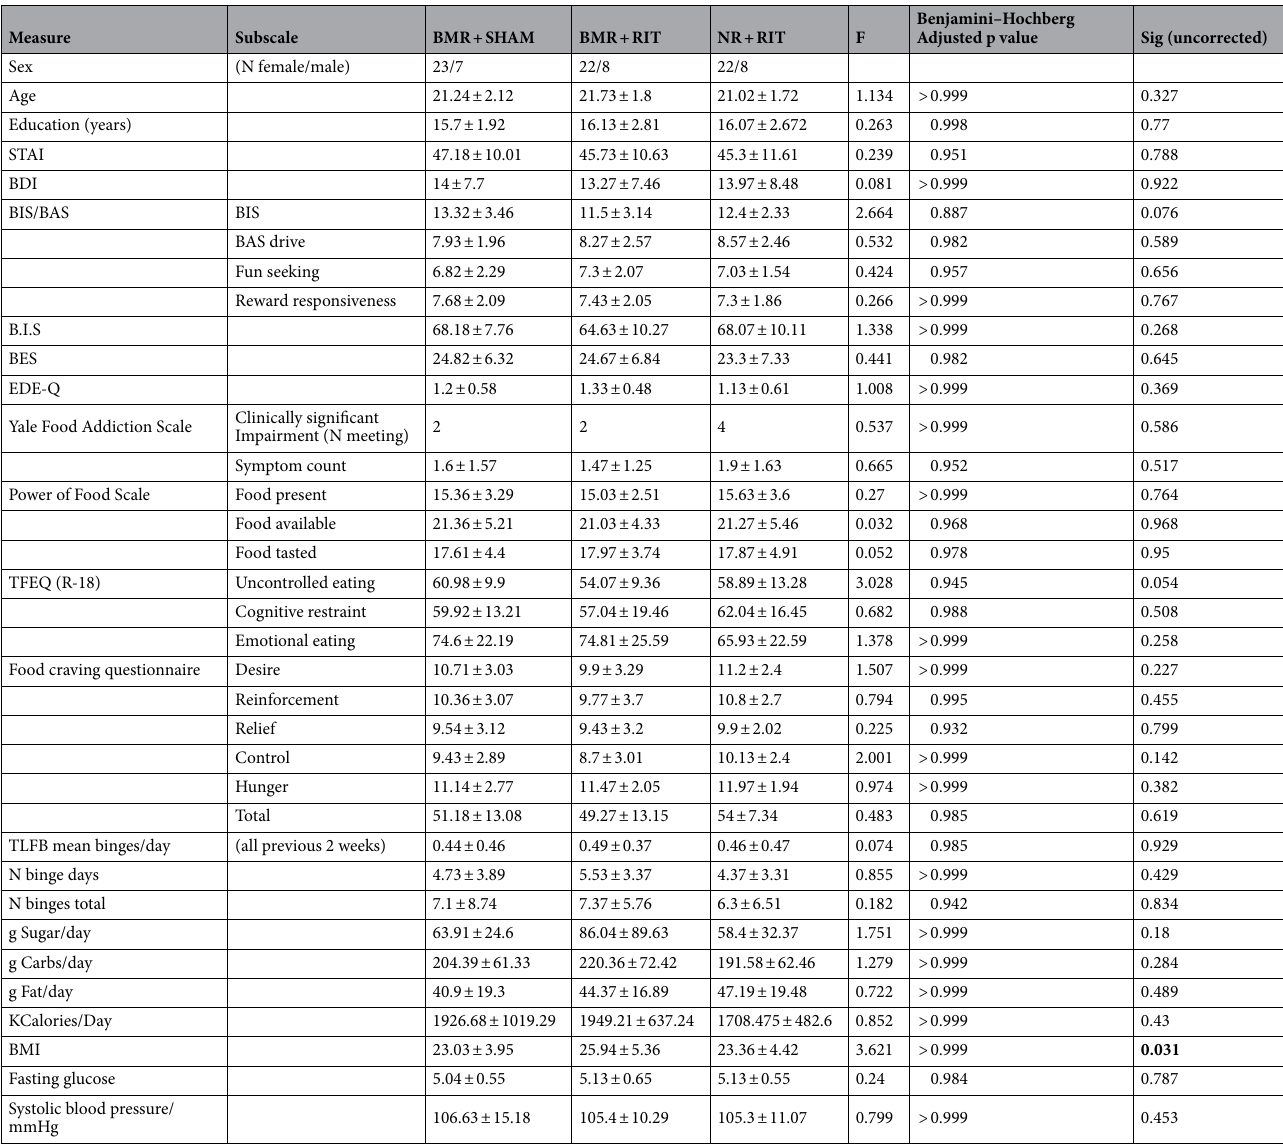
Table 1. Descriptive statistics of demographic variables at baseline. Values represent mean ± SD or counts. F-tests are one-way ANOVA with df 2.87. Significant values are in